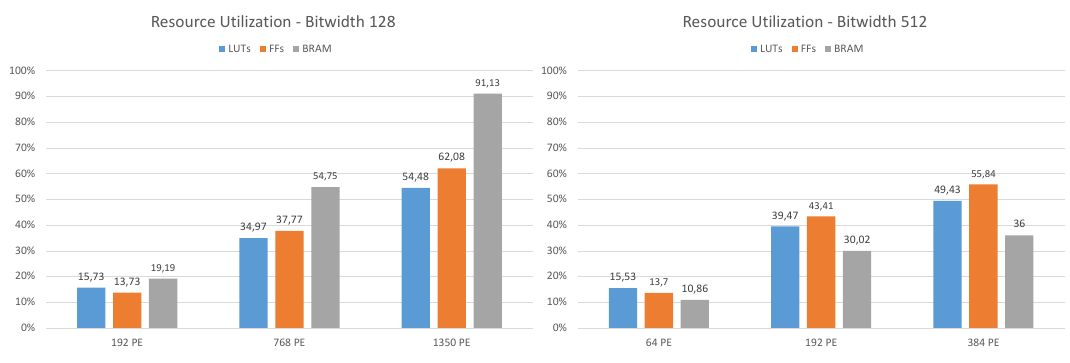
Figure 7. Resource use for bit width 128 and